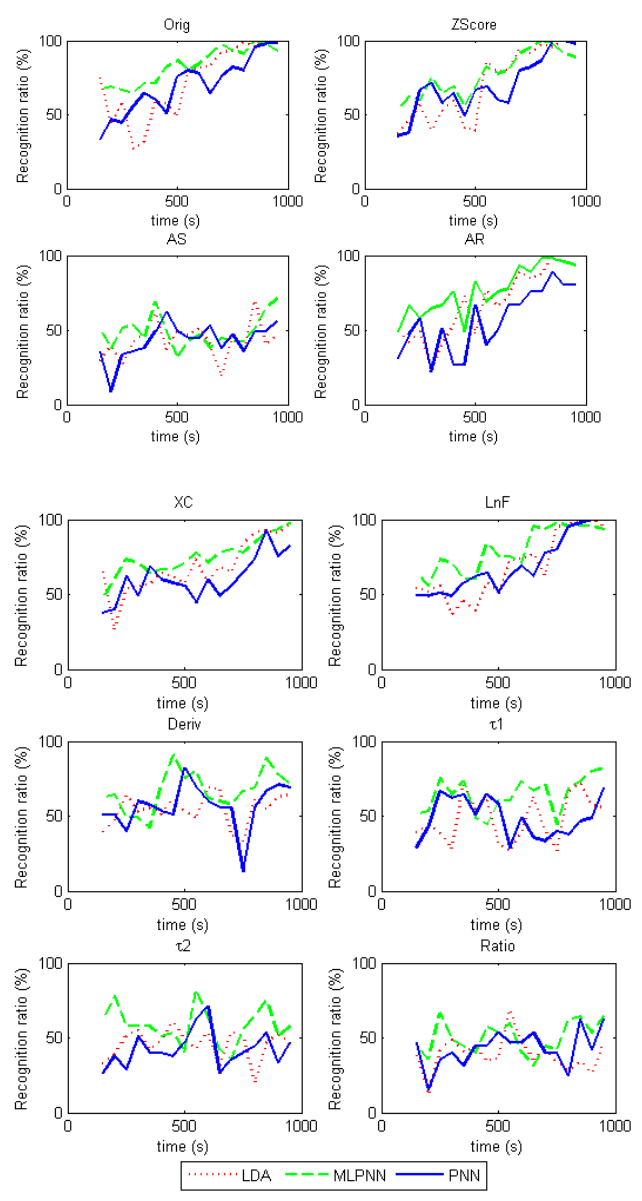
Figure 6. Classification comparison based on three methods using 45 measurements.